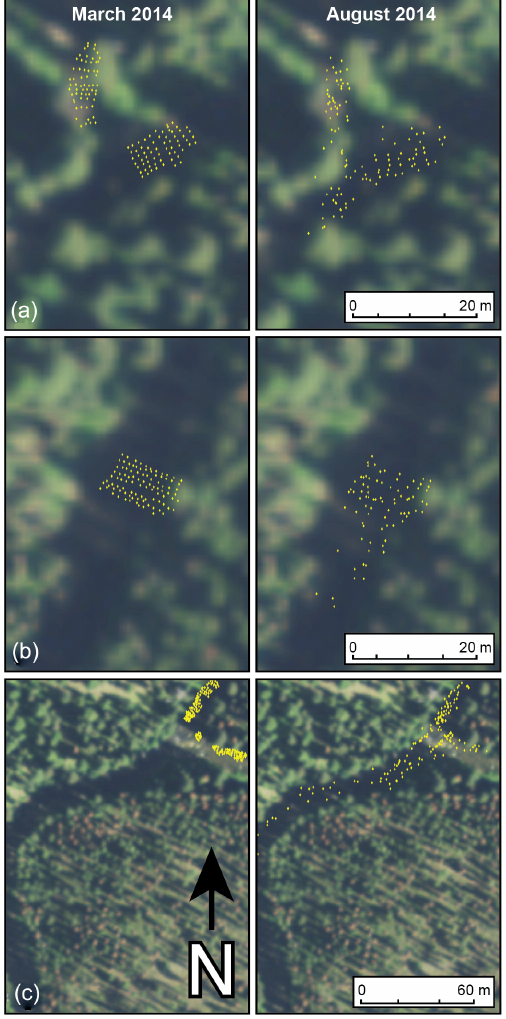
Figure 5. Tracer positions at initial installation (left) and following the 2014 flood (right) at (a) the upper confluence, (b) the control reach, and (c) the lower-confluence